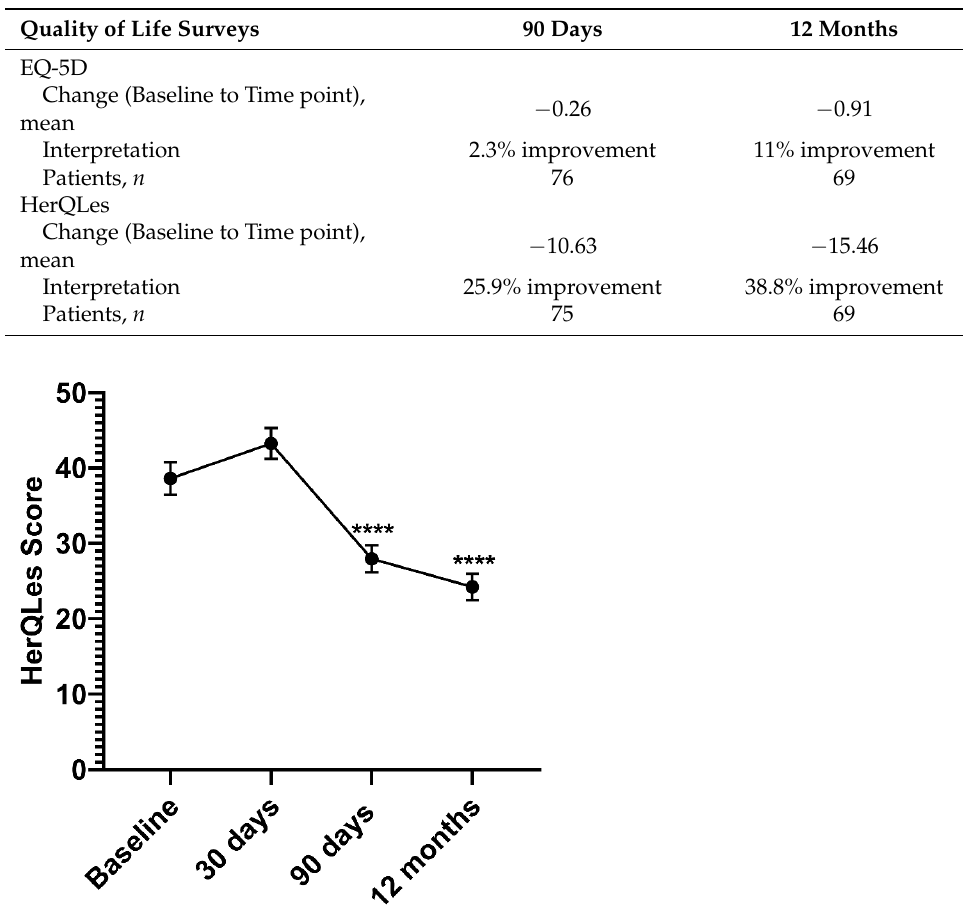
Figure 2. Probability of Hernia-Free Survival. Kaplan–Meier estimate of probability of hernia recurrence in the patient population indicated by Kaplan-Meier curve (red line). Fraction of patients with hernia recurrence 3 and 12 months post-surgery. n = 75. Standard error. Table 5. Secondary Endpoints: Quality of Life Surveys.